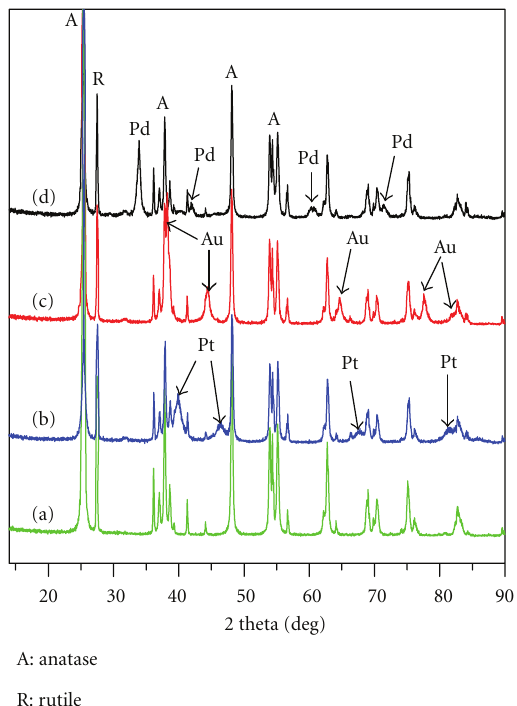
Figure 2: XRD patterns of as-prepared TiO 2 films (a), Pt-TiO 2 (b), Au-TiO 2 (c), and Pd-TiO 2 (d) nanocomposite films scratched from Ti wire